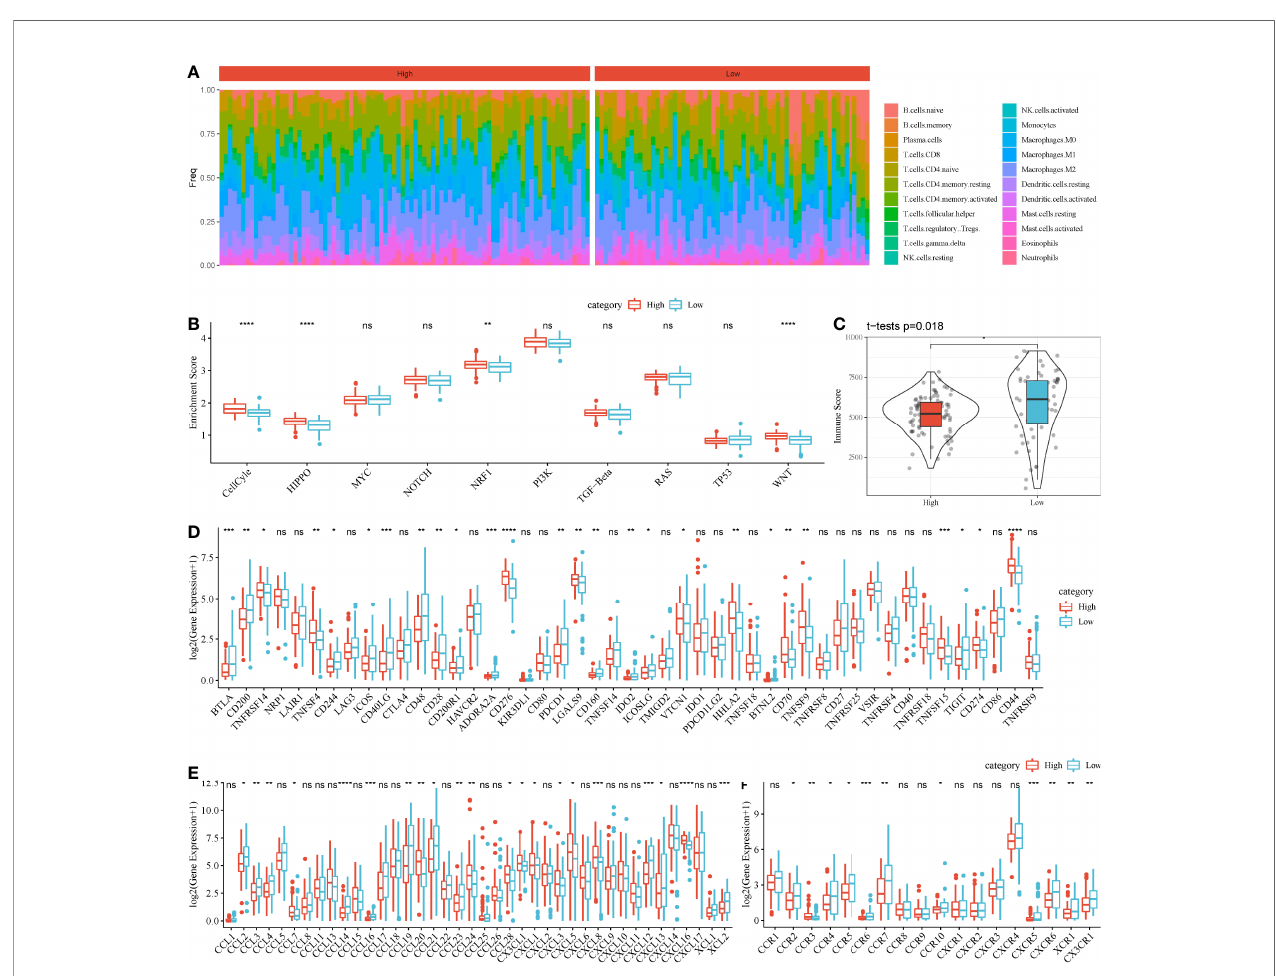
FIGURE 8 | Comparison of TME between high-risk and low-risk groups in TCGA-PAAD cohort. (A) A heatmap describing distribution of 22 immune cells in high-risk and low-risk groups. (B) Enrichment score of 10 oncogenic pathways in high-risk and low-risk groups. (C) Immune score of high-risk and low-risk groups. (D – F) Expression of immune checkpoints (D) , chemokines (E) , and chemokine receptors (F) in two groups. Student t -test was performed between two groups. ns, no signi fi cance. * P < 0.05, ** P < 0.01, *** P < 0.001, and **** P <